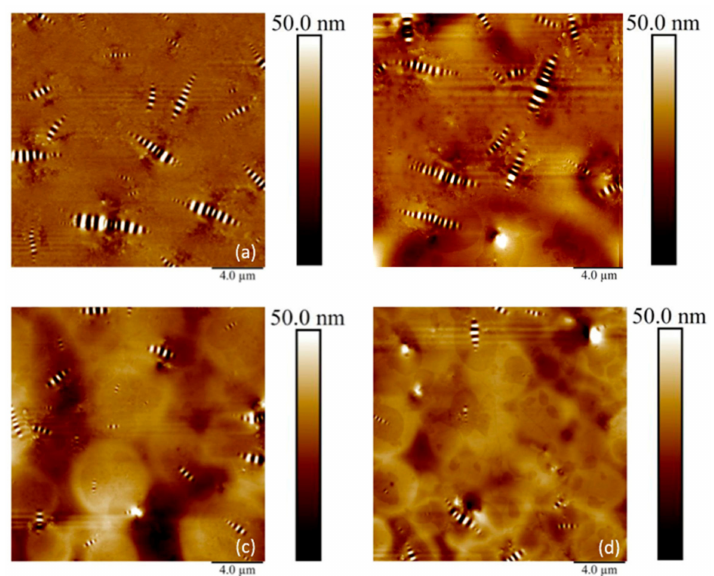
Figure 15. Atomic force microscopy (AFM) images of styrene–isoprene–styrene (SIS)-modified asphalt binders; ( a ) SIS 0% ( b ) SIS 5% ( c ) SIS 10% ( d ) SIS 15%.